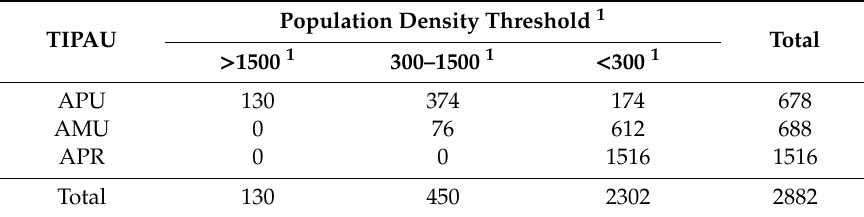
Table 3. Number of parishes by TIPAU class and population density threshold.